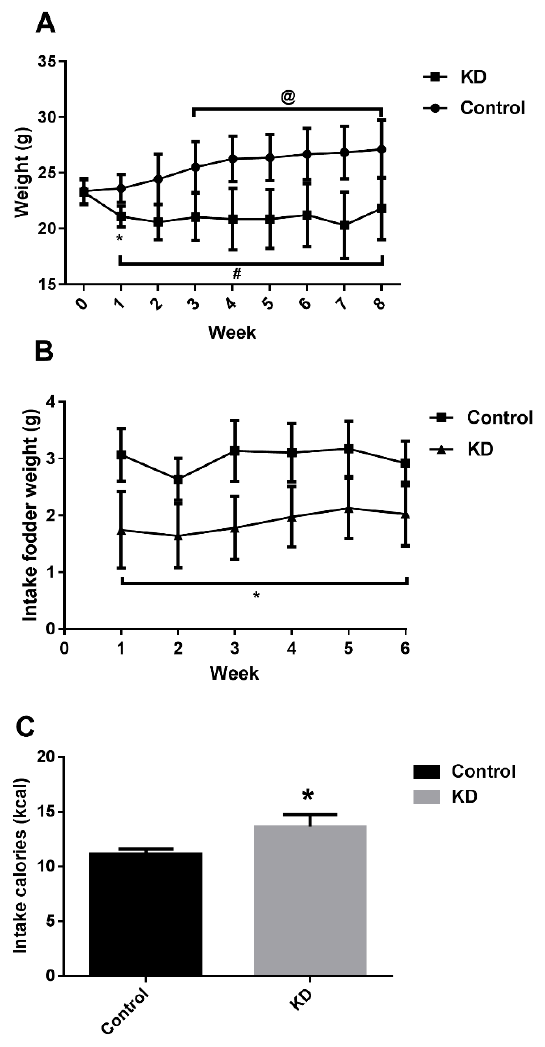
Figure 1. Effects of different diet feeding on weight and energy intake. ( A ) 8-week of ketogenic diet (KD) feeding led to significant weight loss. * p < 0.01, compared with KD week 1. @ p < 0.01 compared with chow week 1. # p < 0.01 compared with chow of the same week. ( B ) Food intake (daily, individually) variation throughout the experimental period. * p < 0.01, compared with chow of the same week. ( C ) Caloric intake was greater in KD-feeding mice than in chow diet-feeding mice. * p < 0.001 vs. chow.